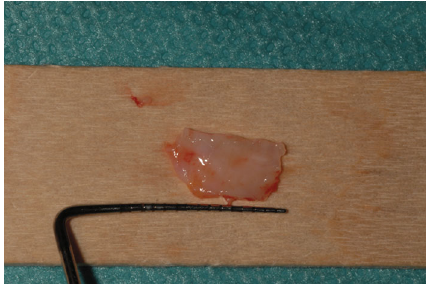
Figure 5: Folded connective tissue graft sutured at the defect site.